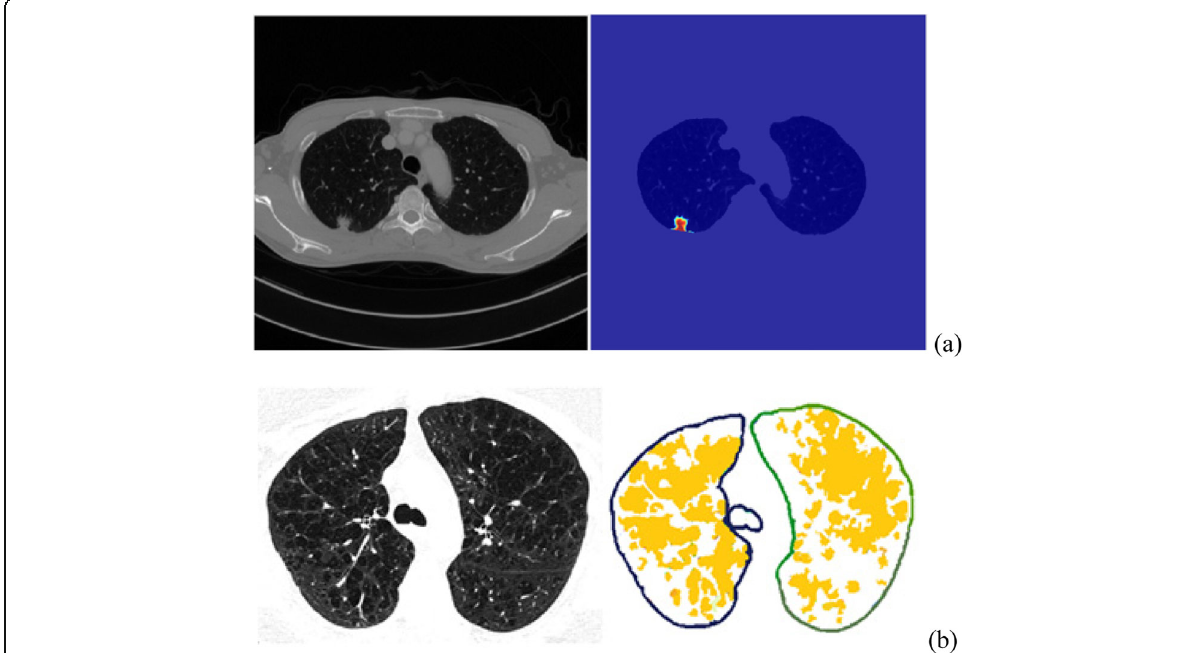
Fig. 2 Illustration of segmenting lung tumor marked by red color and bright boundary ( a ) and segmenting emphysema regions marked by yellow color using a density mask ( b )